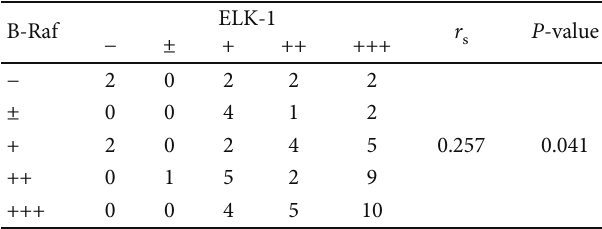
Table 8: The relationship between B-Raf and ELK-1 protein expression in colon cancer